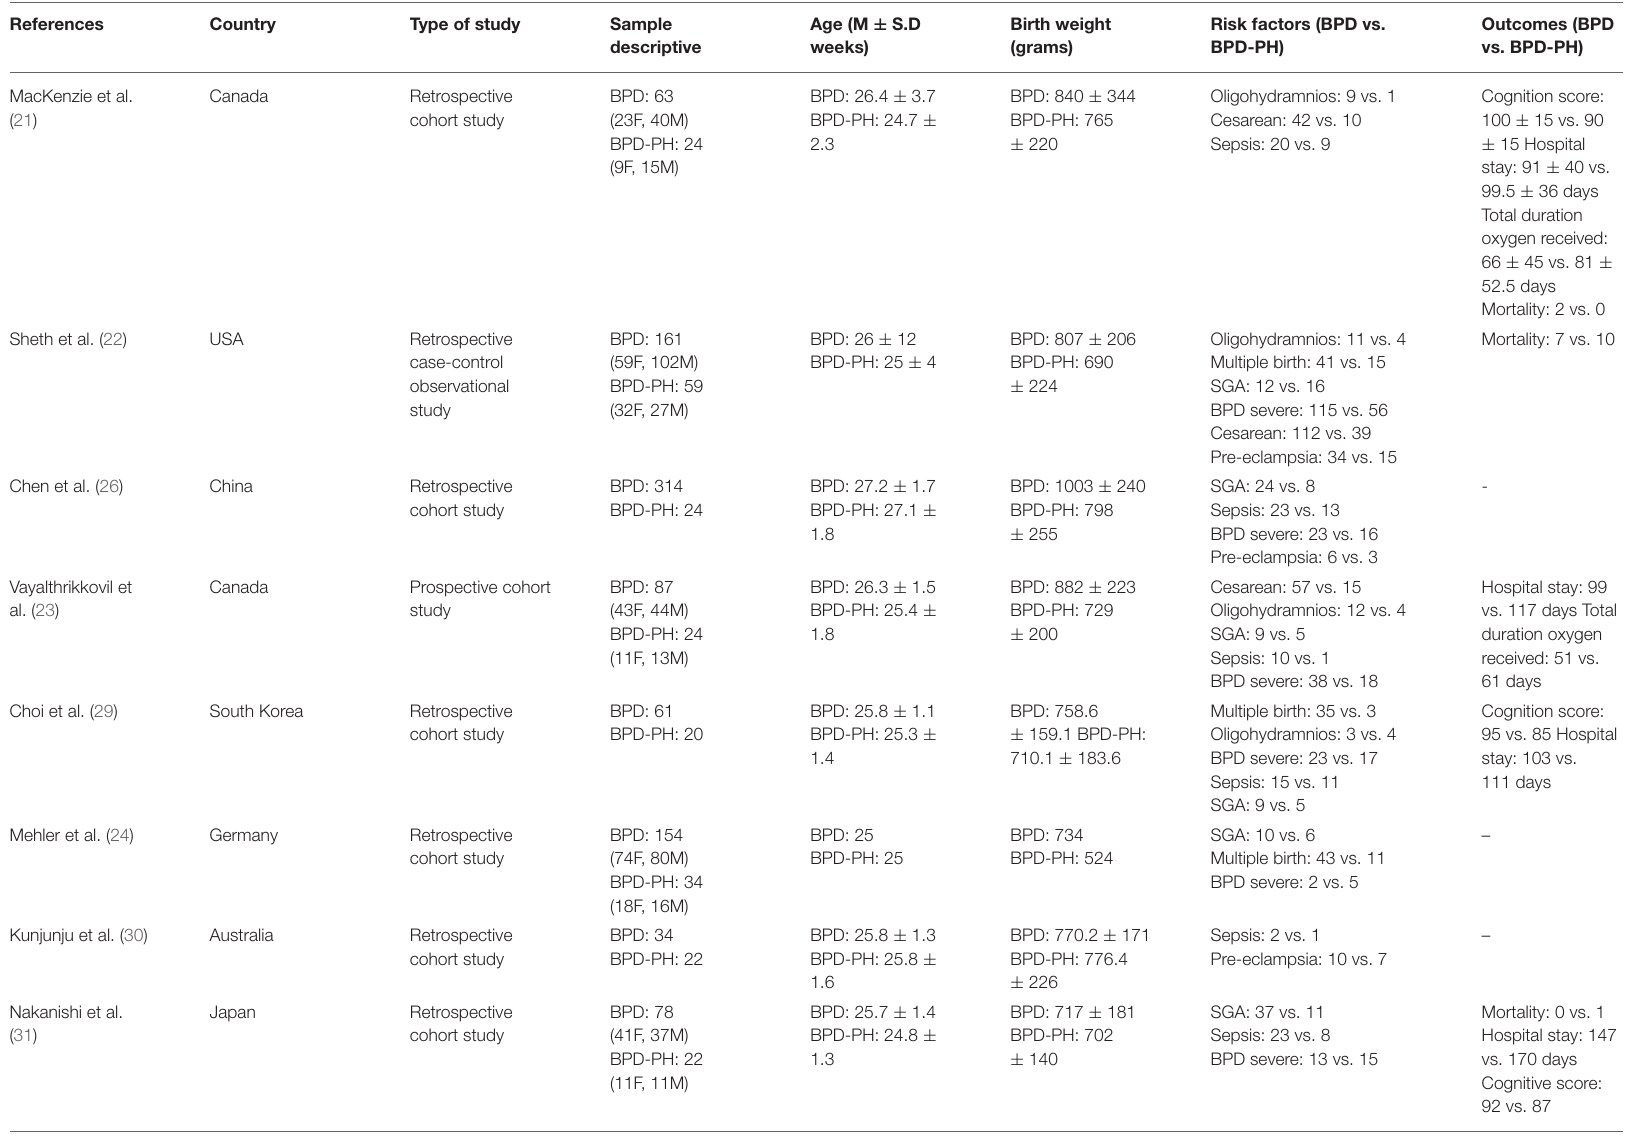
TABLE 1 | Characteristics of the included studies.